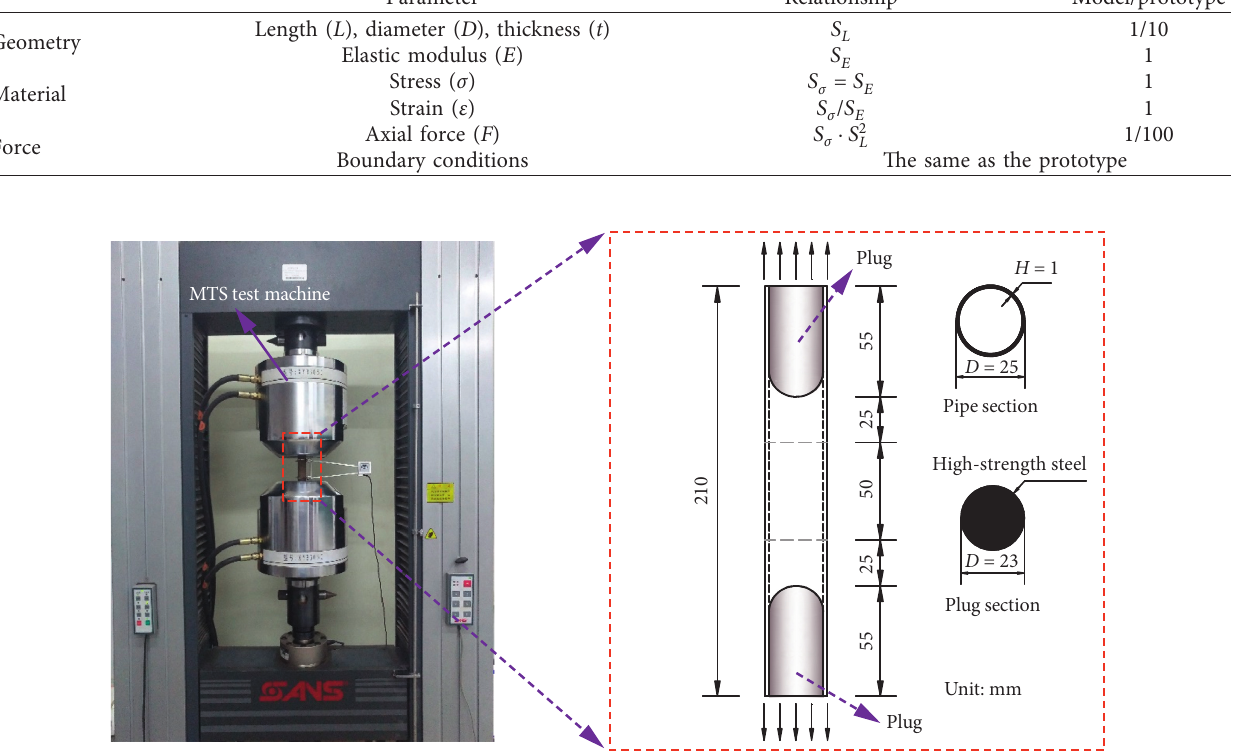
Figure 1: Tensile test setup and specimen size.